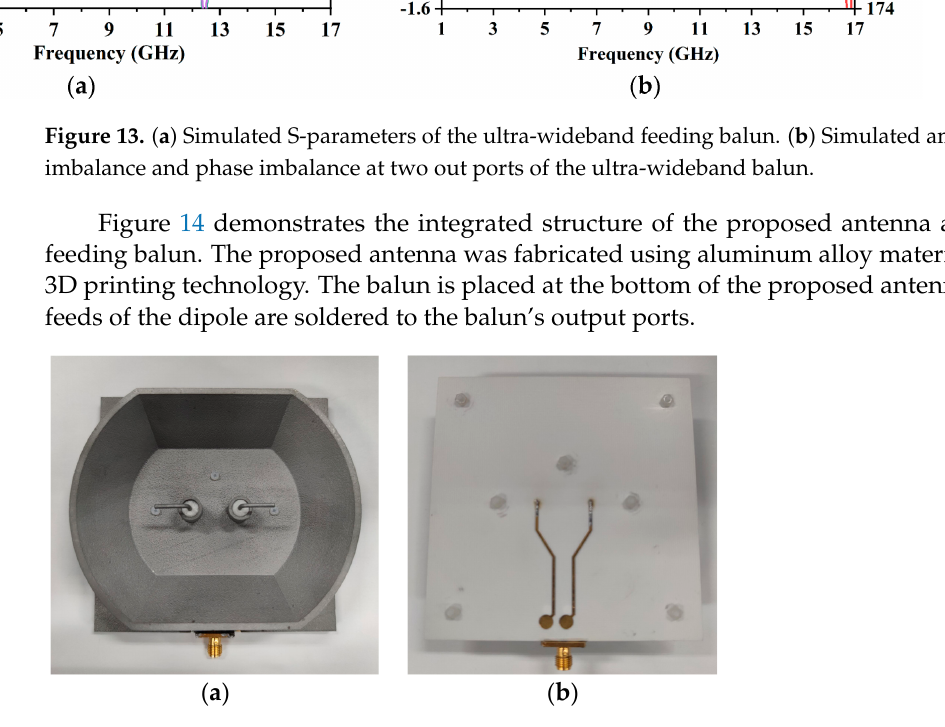
Figure 14. Integrated structure of the proposed antenna and the ultra-wideband balun. ( a ) top view; ( b ) bottom view.